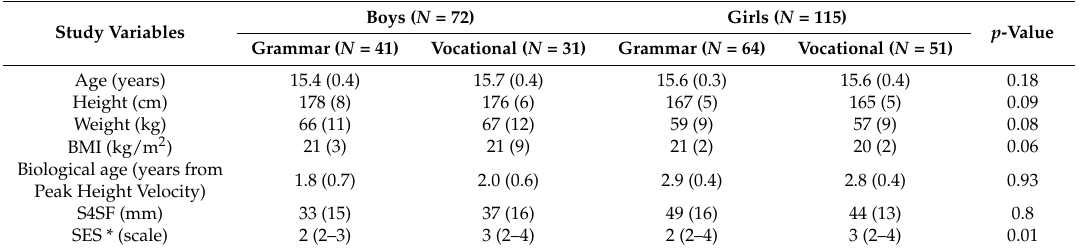
Table 1. Basic characteristics of the study participants, stratified by the gender and the type of school.